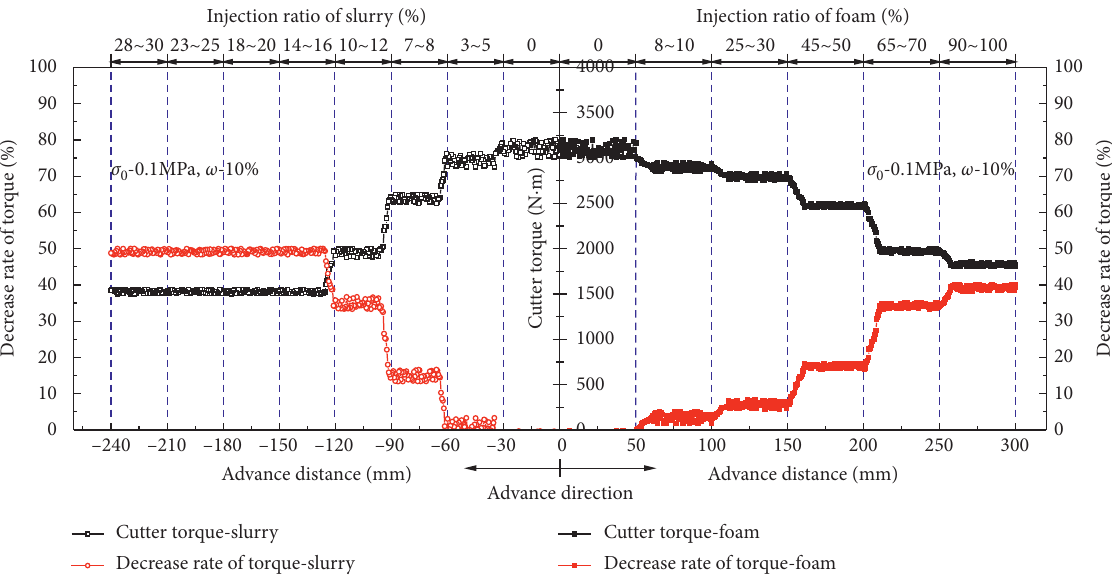
Figure 30: Effect of two types of soil conditioners on cutter torque at water content 10% and soil pressure 0.1MPa.